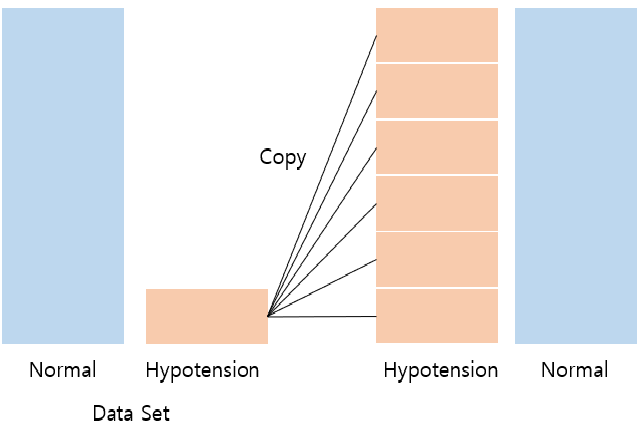
Sensors 2022 , 22 , x FOR PEER REVIEW Figure 7. Up-sampling of hypotension class to resolve the class imbalance. Figure 7. Up-sampling of hypotension class to resolve the class imbalance.